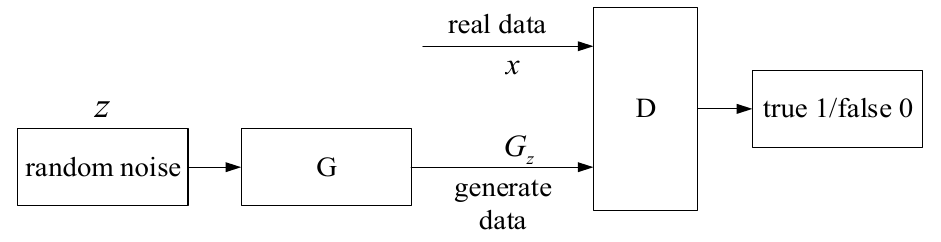
Figure 1. GAN structure diagram.